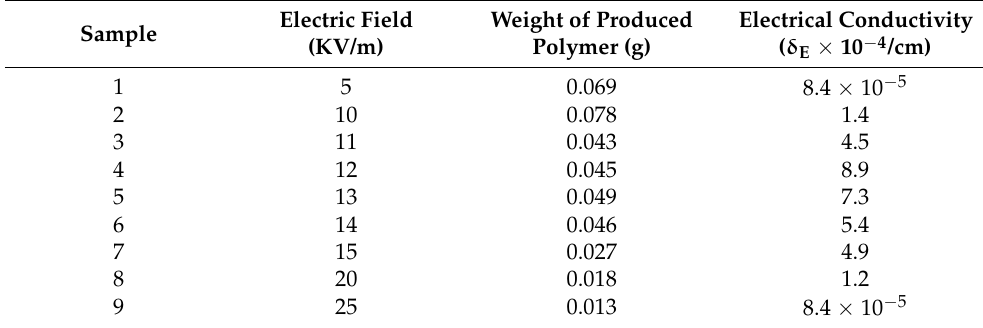
Table 5. Electrical conductivity of polycarbazole produced with FeCl 3 (dry) (PTSA 1M in acetone) as the initiator (1/5 mol ratio) in different electric fields after 3 h.